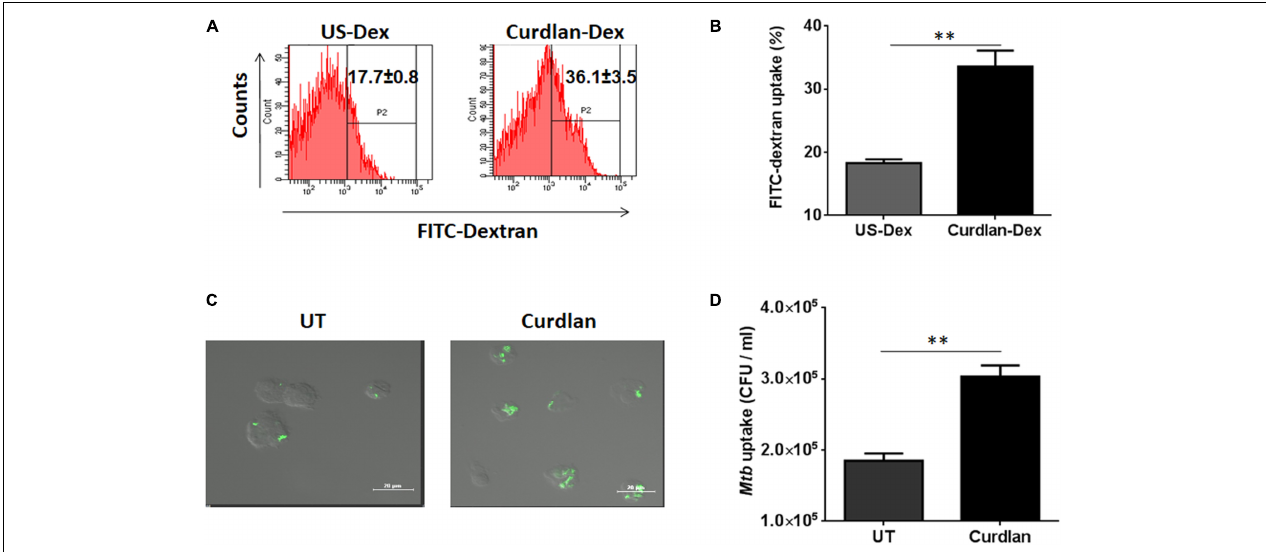
FIGURE 2 | Stimulation through curdlan enhances the phagocytic ability of M (cid:56) s. (A–D) M (cid:56) s were stimulated with the curdlan (50 µ g/ml) for 48 h. Thereafter, (A,B) cells were incubated with dextran-FITC particles for 30 min at 37 ◦ C and then uptake was examined by flow cytometry. Insets of flow cytometry plots and bar graph show percentage of positive cells gated on macrophage population, US-Dex: unstimulated macrophages incubated with dextran-FITC, Curdlan-Dex, curdlan stimulated macrophages incubated with dextran-FITC. (C) Curdlan stimulated cells were infected with Mtb GFP [green] and after 4 h, phagocytosis was monitored by confocal microscopy. (D) Curdlan activated cells were infected with Mtb H37Rv and 4 h post infection, uptake was evaluated by CFU assay. UT: Mtb infected M (cid:56) s; Curdlan: Mtb infected and curdlan stimulated M (cid:56) s. Data represented as mean ± SD and representative from two independent experiments. ∗∗ p ≤ 0.01.